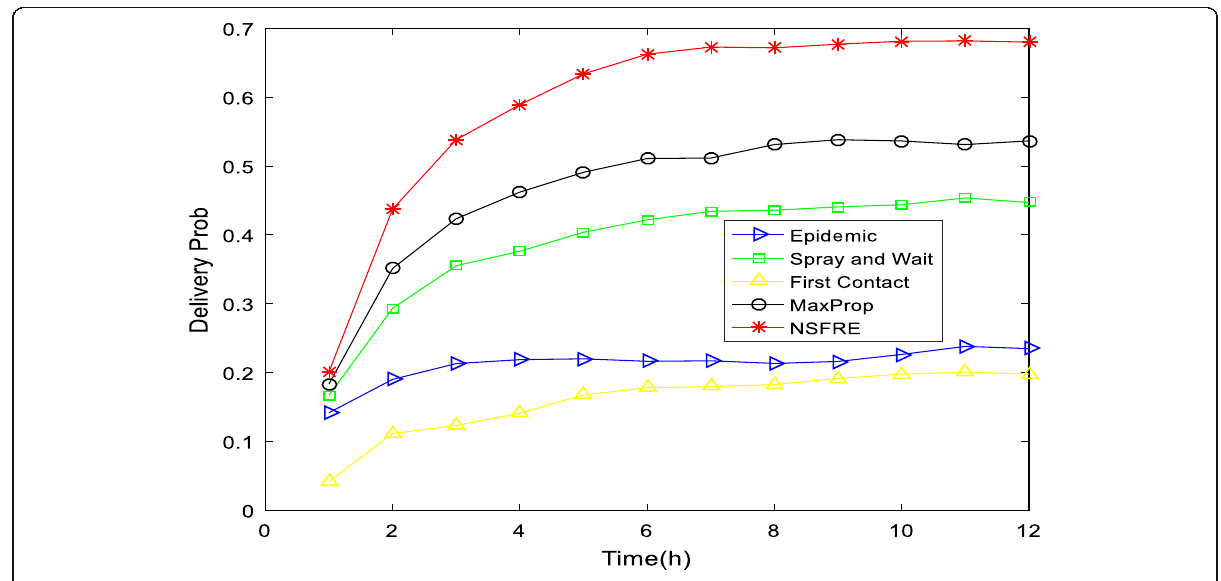
Fig. 4 The relationship between transmission success rate and simulation